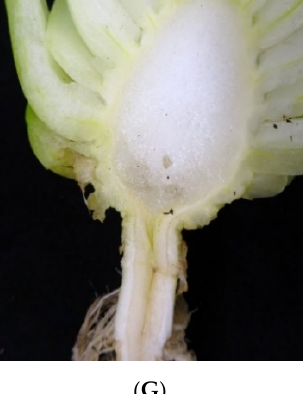
Figure 1. Grafted plants with ‘Mei Qing Choi’ pac choi as scion and ‘Bora King’ daikon radish as rootstock. ( A ) A well-healed grafted pac choi–daikon radish seedling. ( B ) Formation of the taproot of daikon radish grafted with pac choi. ( C ) Longitudinal section of the grafted pac choi–daikon radish plant at harvest. ( D ) Comparison between self-grafted ‘Bora King’ (left), ‘Mei Qing Choi’ pac choi grafted onto ‘Bora King’ daikon radish (middle), and non-grafted ‘Bora King’ (right) at harvest. ( E ) Longitudinal section of the graft union area of grafted pac choi–daikon radish plant at harvest. ( F ) Longitudinal section of the graft union area of self-grafted ‘Bora King’ daikon radish at harvest. ( G ) Longitudinal section of the graft union area of self-grafted ‘Mei Qing Choi’ pac choi plant at harvest.